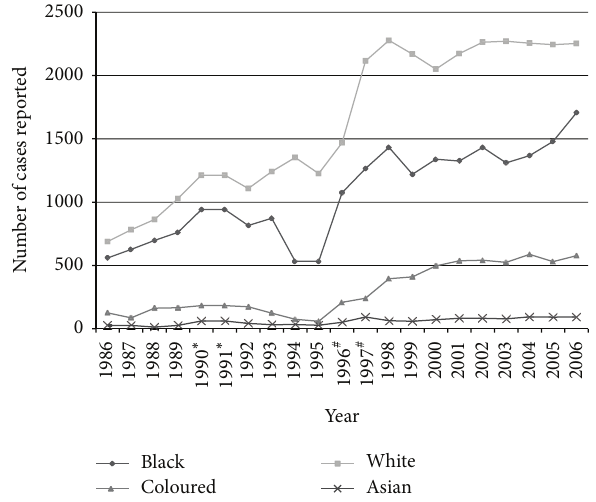
Figure 1: Number of prostate cancer cases reported to the South African pathology based National Cancer Registry (NCR) from 1986 to 2006 by the population groups; white, black, coloured, and Asian/Indian. # 1996 and 1997 coloured and whites were pooled together in the published report but NCR provided the number of cases per year. ∗ Years 1990-1991 were combined and reflect the average number of reported cases over the two years.